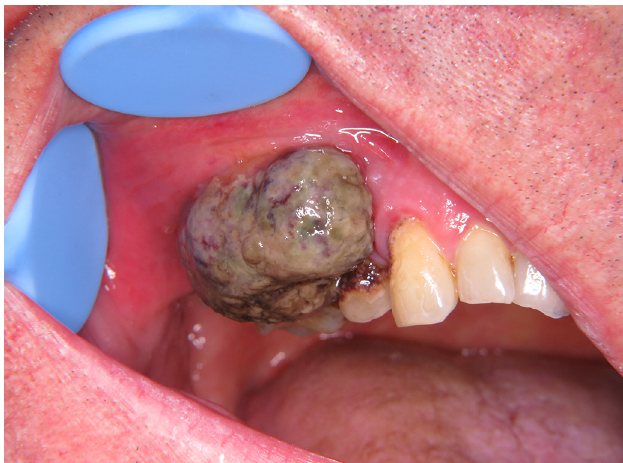
Fig. 1. Clinical picture showing the exuberant vestibular clot.